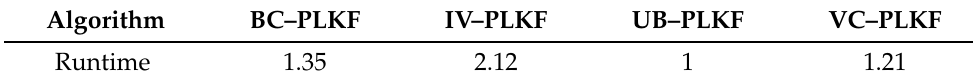
Table 2. Normalised runtimes for the 4